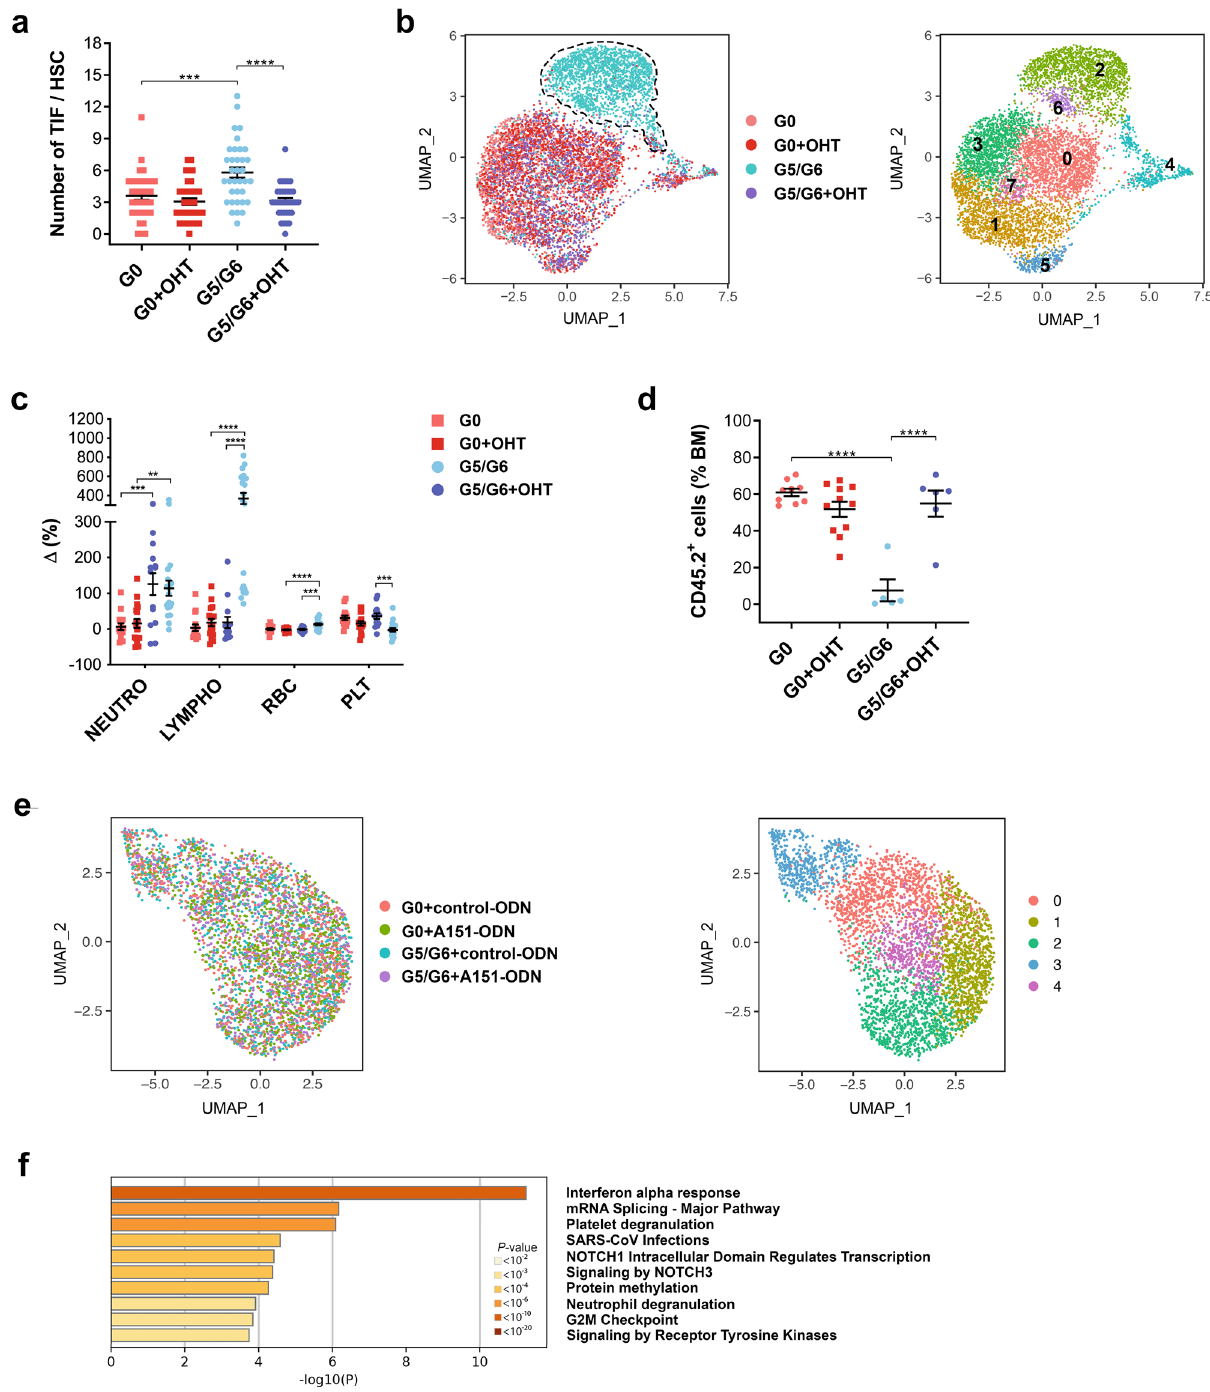
For example, mouse embryonic stem cells with short